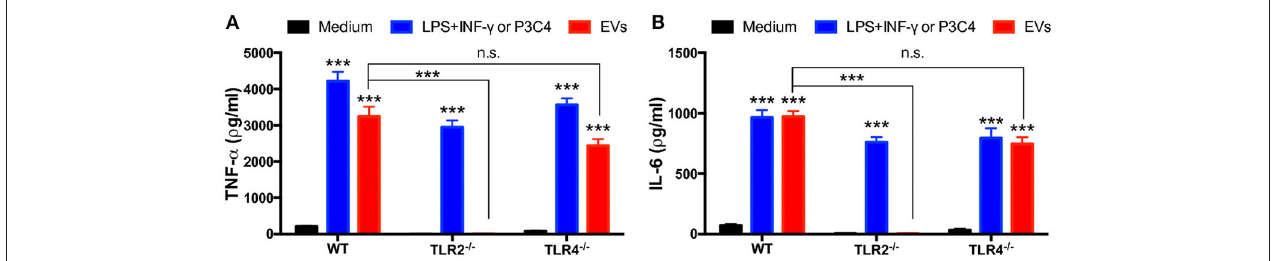
FIGURE 5 | Involvement of TLR2 and TLR4 in the proinflammatory cytokine production induced by T. interdigitale EVs. Bone marrow-derived macrophages (BMDMs) obtained from WT, TLR2 − / − , and TLR4 − / − mice were incubated at 37 ◦ C for 48h with EVs (10 7 particles/mL). A mixture of LPS (1 µ g/mL) plus IFN- γ (2ng/mL) were used as positive controls for WT and TLR2 − / − macrophages; Pam3CSK4 (100ng/mL) was used as the positive control for TLR4 − / − macrophages. The cultures supernatants were assessed for the concentration of TNF- α ( A ) and IL-6 ( B ). Data are representative of 3 experiments. The results are expressed as means ± SEM and are shown relative to the levels in non-stimulated cells (medium only). *** P < 0.001, and non-significant differences (n.s.).